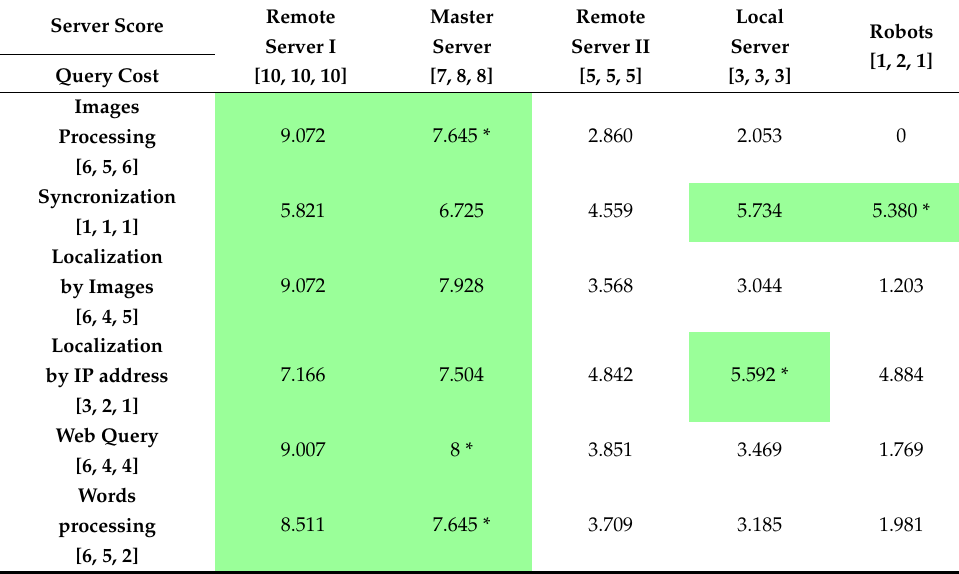
Table 9. saaq score values for our motivating